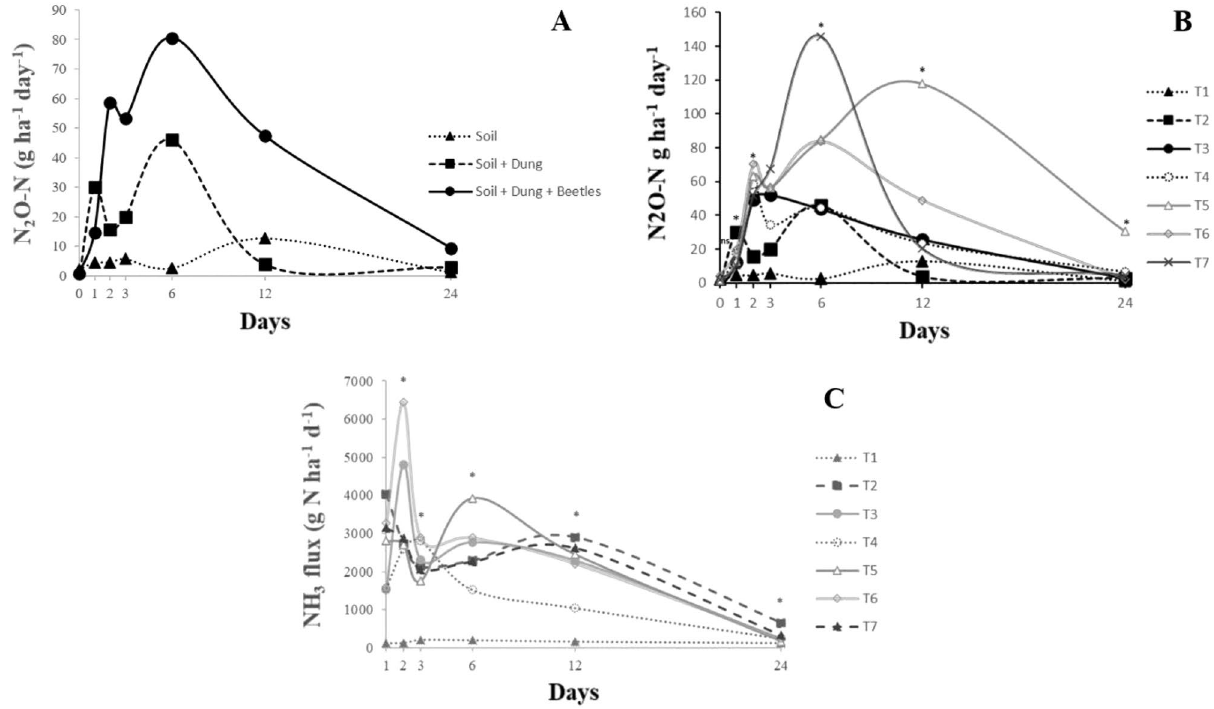
Figure 1. Nitrous oxide flux and ammonia volatilization from soil, soil + dung, and soil + dung + dung beetles over a 24-d period. ( A ) Nitrous oxide flux average of all dung beetle treatments vs. their control, ( B )